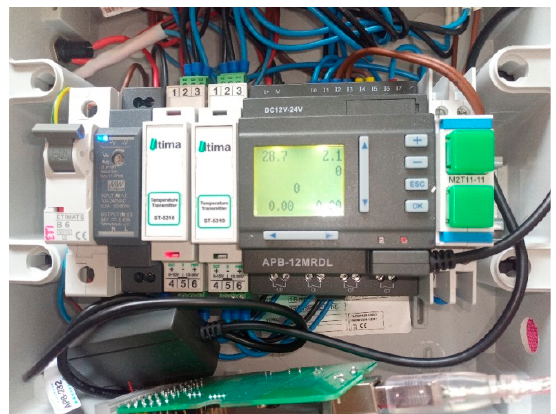
Figure 1. The PLC during operation. From the left: the circuit breaker, the power supply, the temperature transducers, the PLC, optional switch; below: the PLC–PC interface.